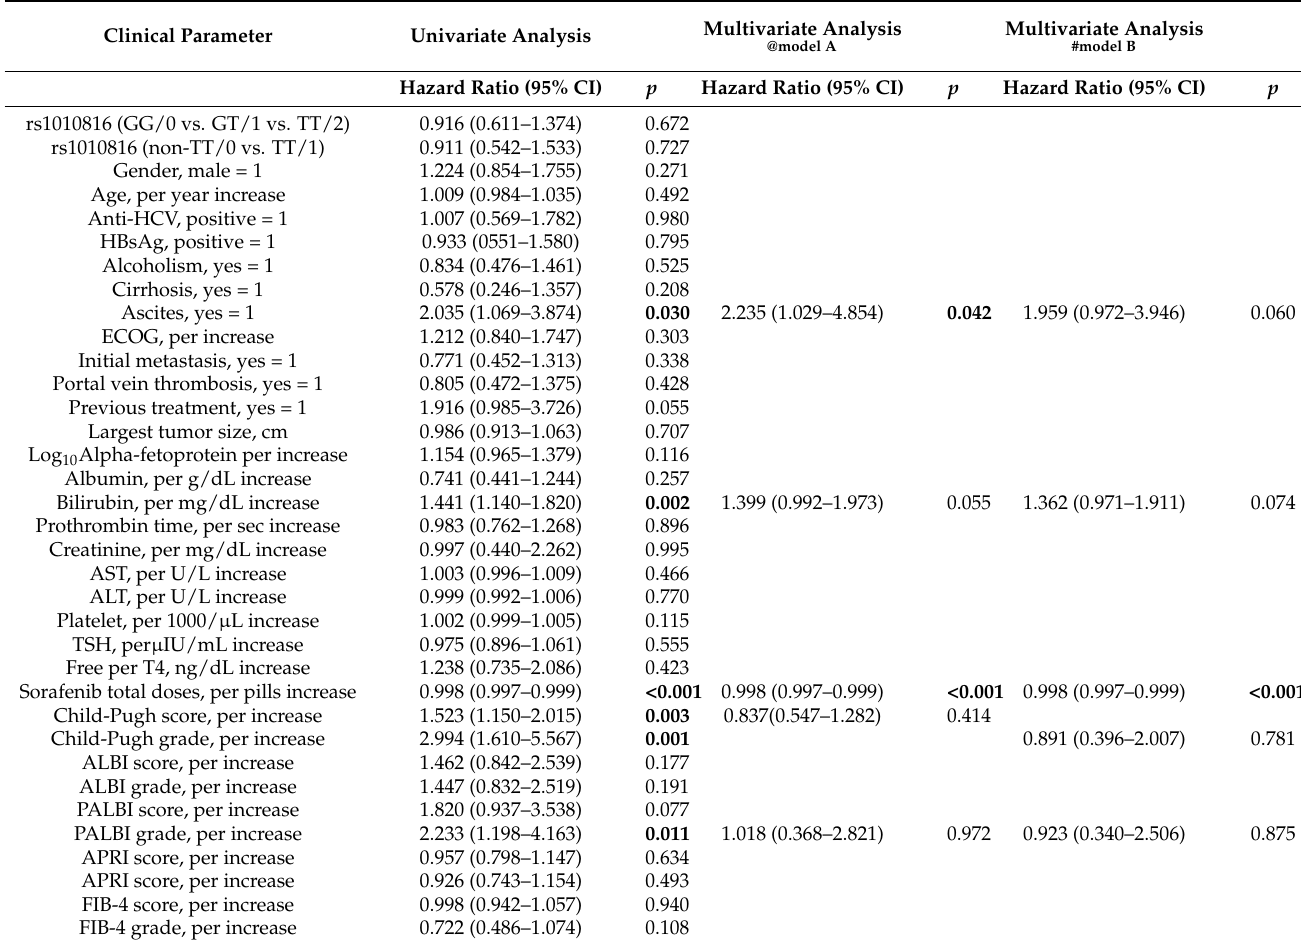
Table 3. Cox proportional hazard analysis for association between genetic and clinical factors and progression free